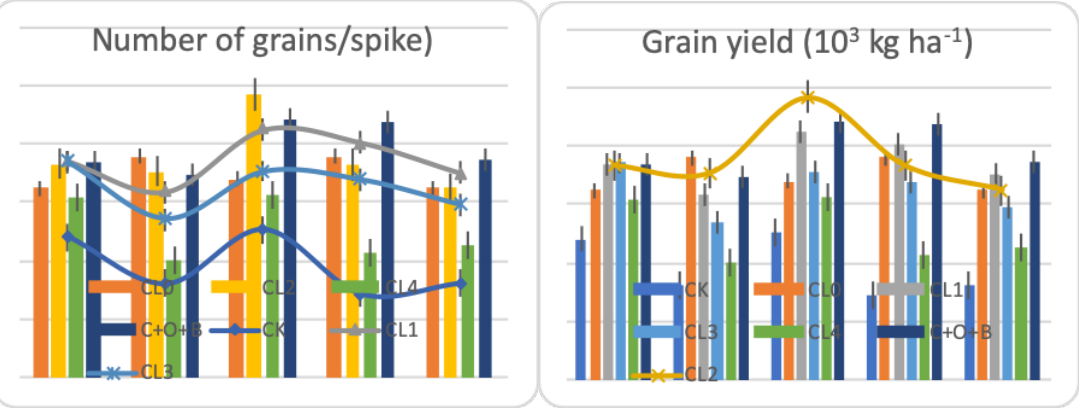
Figure 4. Cumulative evaluation analysis of number of grains/spike and total grain yield (10 3 kg ha −1 ) of winter wheat in the North China Plain during the long-term research intervention 2013 – 2018 (data attached).